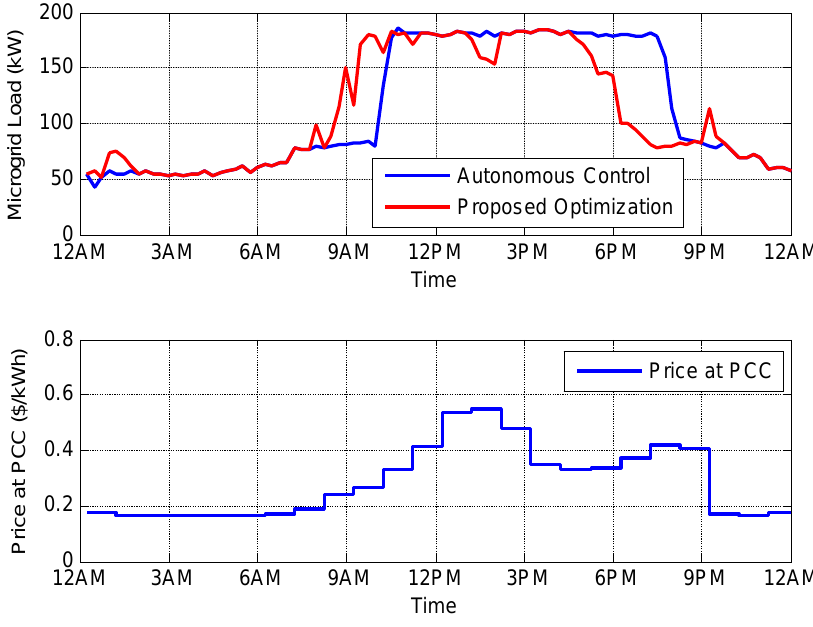
Figure 6. Load shifting in grid-connected